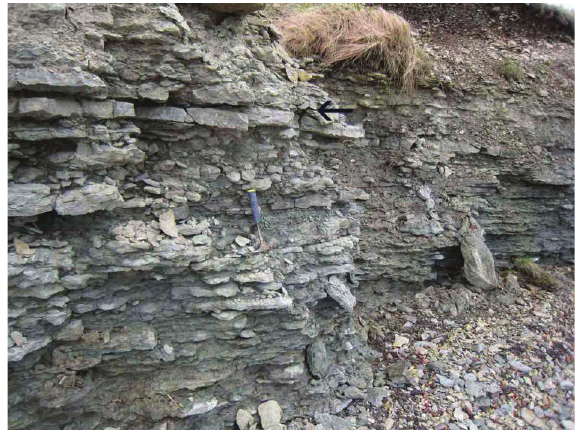
Fig. 3. Ohesaare cliff. The arrow points to beds with Cruziana .